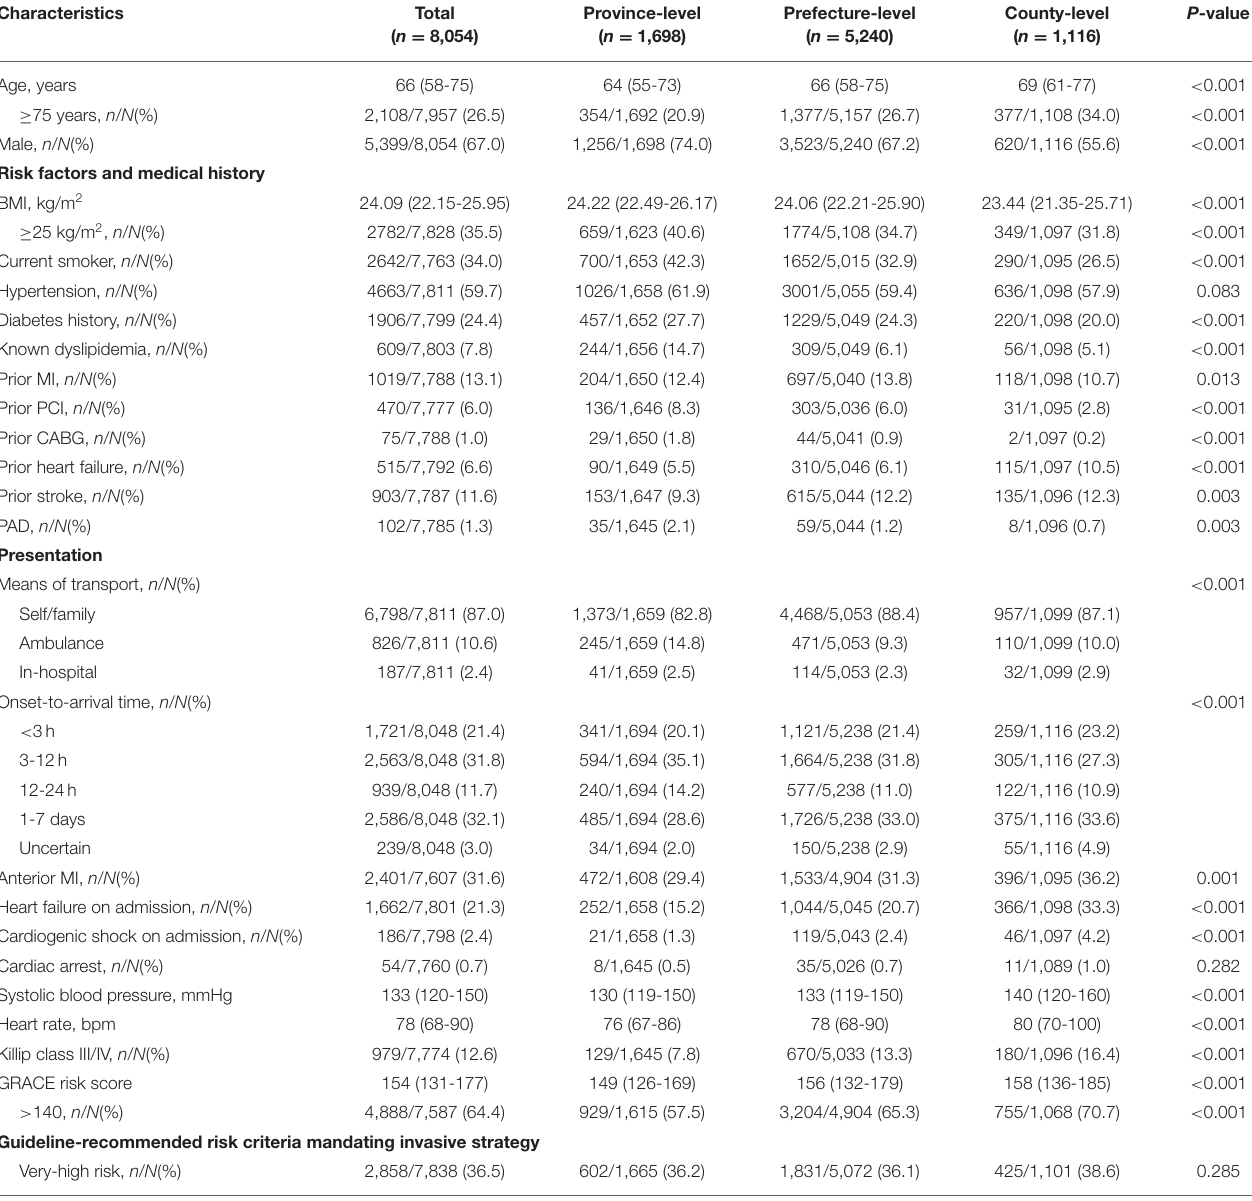
TABLE 1 | Baseline characteristics of patients with NSTEMI among the three hospital levels.